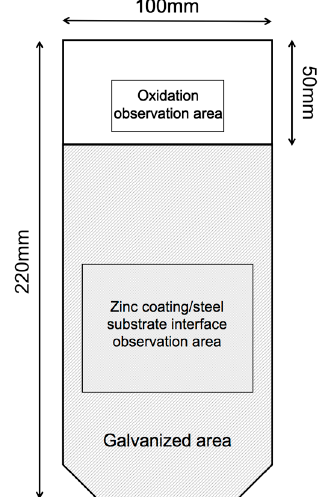
Figure 1. Sampling diagram of galvanizing steel.